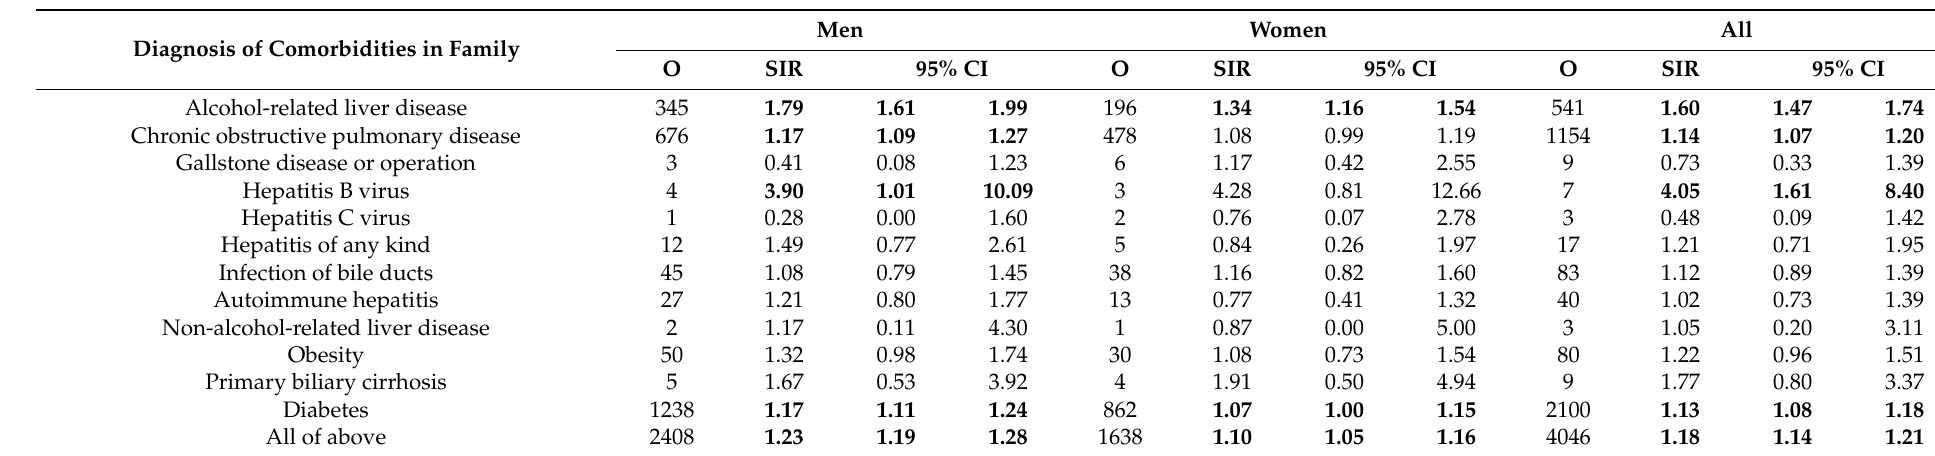
Table 6. Familial risks of hepatobiliary cancer when family members were diagnosed with comorbidities,